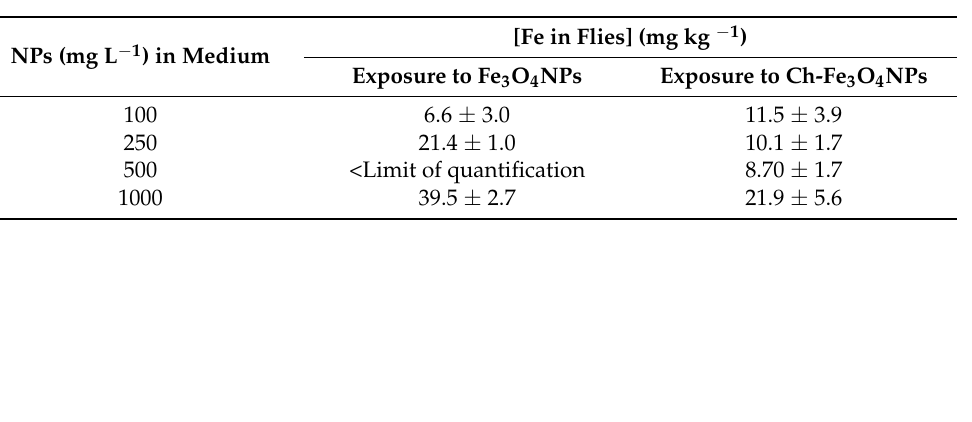
Figure 5. Correlation between added Fe 3 O 4 NPs and observed iron concentrations in the culture medium.